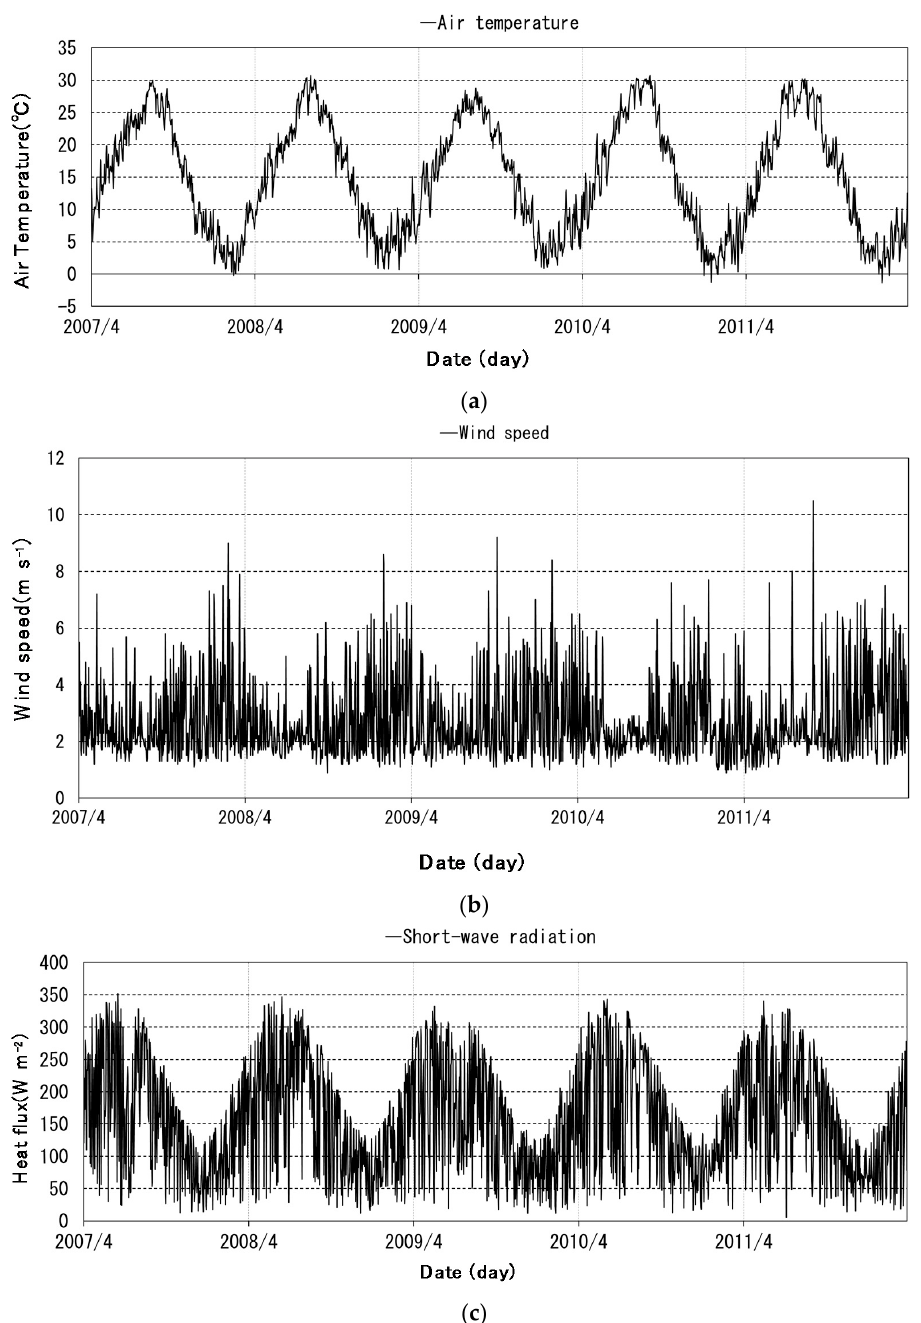
Figure 2. Time series of ( a ) Air temperature; ( b ) Wind speed; and ( c ) Short-wave radiation for boundary conditions from 2007 to